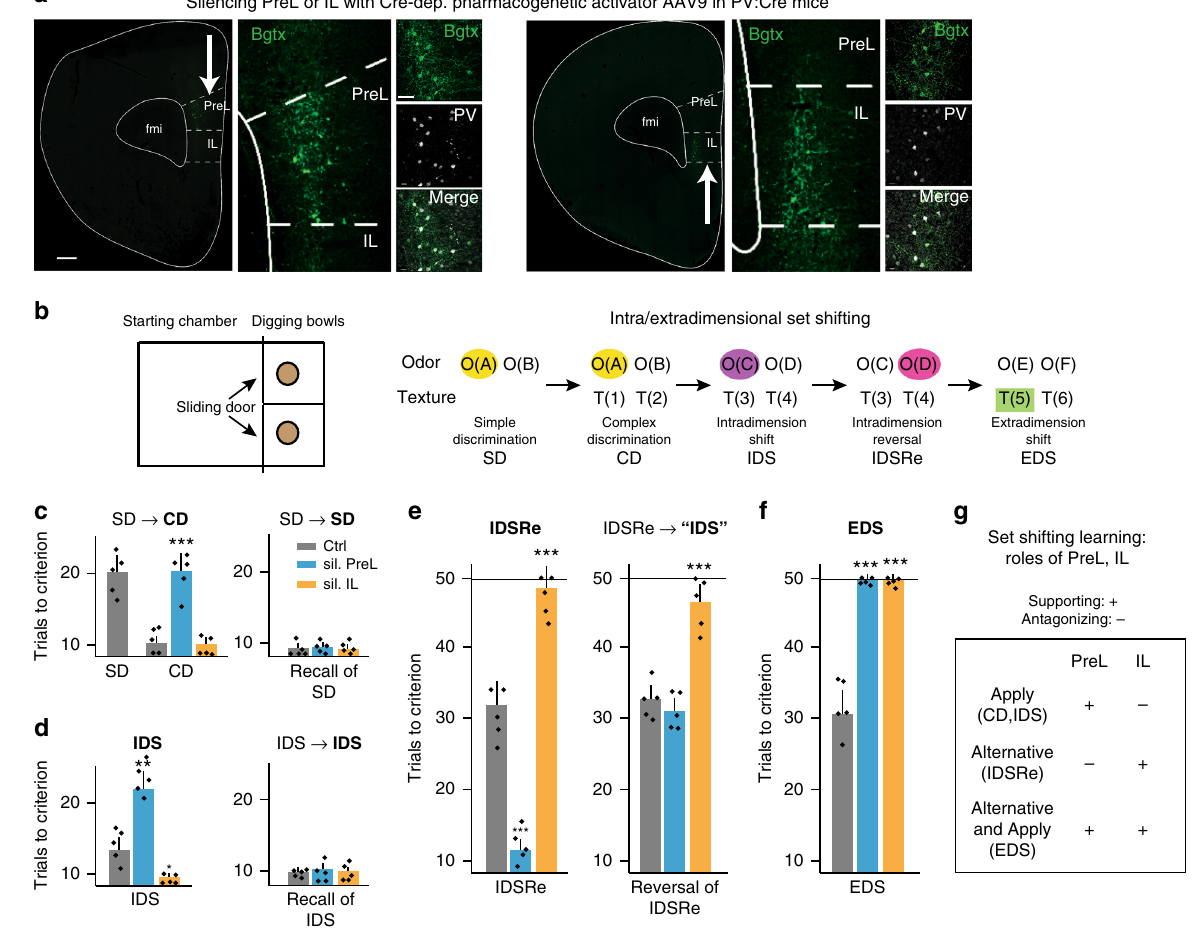
Fig. 2 PreL is required to apply and IL to shift from learnt rules. a Representative images for delivery to PreL or IL of Cre-dependent AAV9-pharmacogenetic activator in PV-Cre mice. Bgtx: visualization of (Bungarotoxin + ) virus infected cells; PV: PV immunocytochemistry. Bar: 100 μ m (left) and 35 μ m (right). b Schematic of set-shifting protocol (background color: rewarded association). c – f Requirements for activity in PreL or IL during IEST subtask learning. c CD ( n = 5 each; ( F (2, 12) = 17.1, *** P ) or recall of SD ( n = 5 each; F (2, 12) = 1.9, P = 0.1916 ns ); d IDS ( n = 5 each; F (2, 12) = 24.62, *** P ) or recall of IDS ( n = 5 each; F (2, 12) = 0.78, P = 0.4722, ns ); e IDSRe ( n = 5 each; F (2, 12) = 233.5, *** P ) or reversal of IDSRe ( n = 5 each; F (2, 12) = 127.9, *** P ); f EDS ( n = 5 each; F (2, 12) = 43.01, *** P ). Bar diagrams: trials to criterion for virus-expressing mice treated with vehicle (Ctrl) or mice in which PreL (blue) or IL